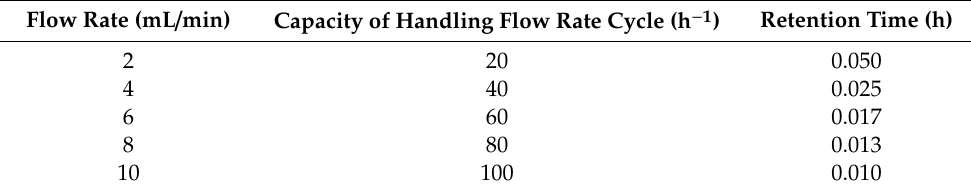
Table 1. Lactose conversion with respect to operation conditions of recirculating column reactor system: feeding flow rate, total recirculation cycle and residence time.